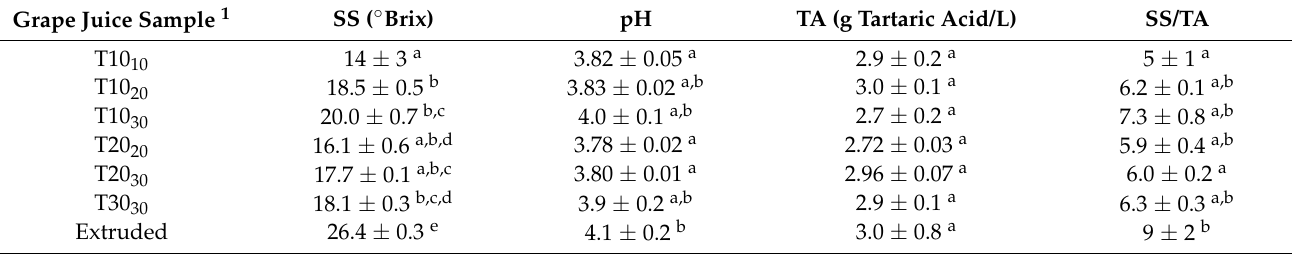
Table 1. The quality parameters of grape juices obtained by steam and mechanical extraction processes. Grape Juice Sample